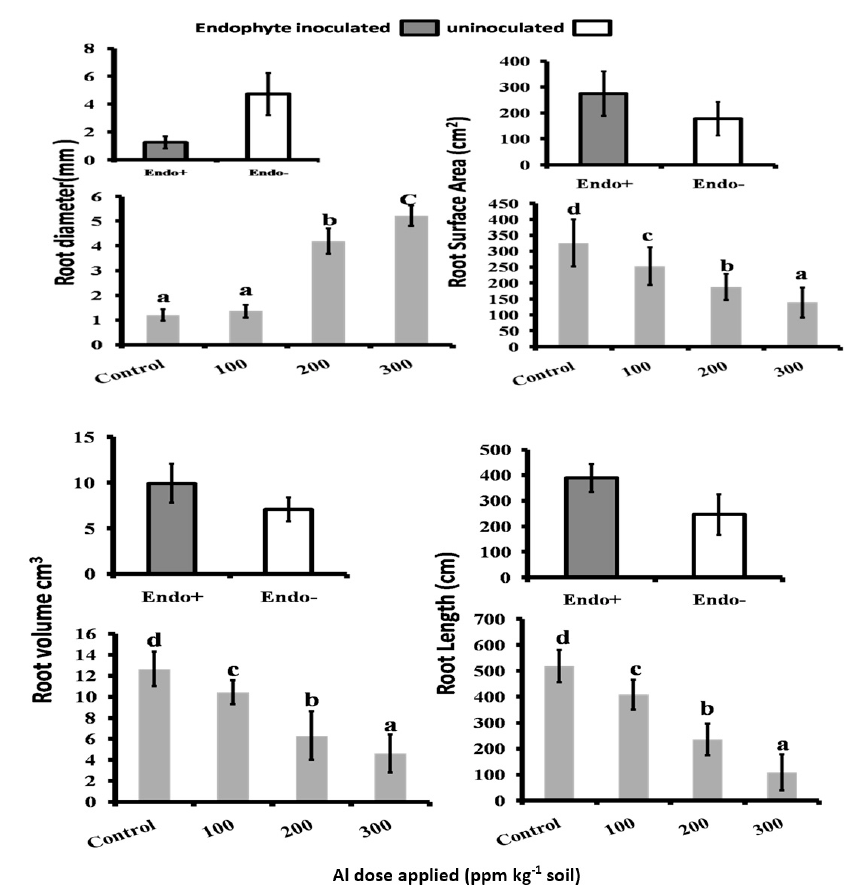
Fig. 2 . Root morphological features: Root Diameter (RD), Root Surface Area (RSA), Root Volume (RV) and Root Lenght (RL) of the rice crop(CAUR3 var) grown under different AI-levels and with and without endophyte inoculation. Statististical Analysis was performed by Two Way ANOVA followed by Turkey’s post hoc comparision with three replications using SPSS v.21 (SPSS Inc., Chicago, IL,